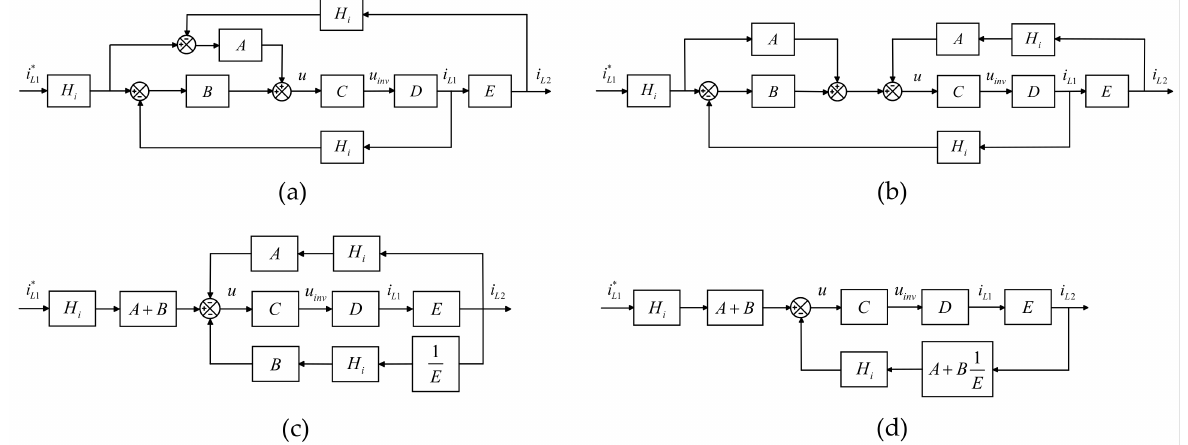
Figure 2. The equivalent control block diagrams of Figure 1b2: ( a ) The original one; ( b – d ) The simplified